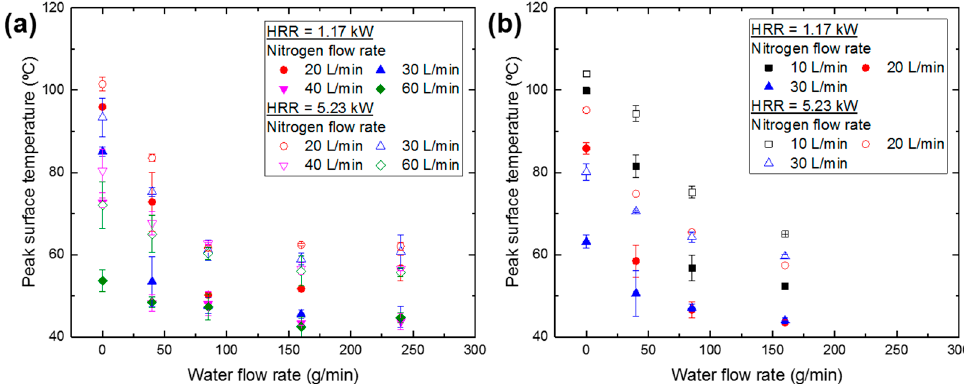
Figure 5. Peak surface temperature for large and small atomizers under different HRR conditions: ( a ) large atomizer and ( b ) small atomizer.